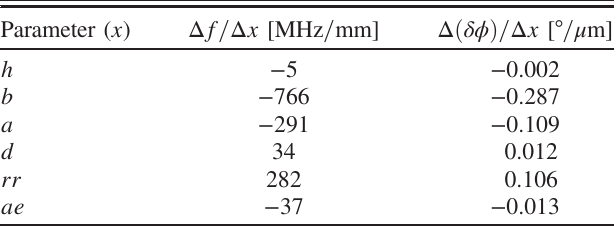
TABLE VI. Sensitivity analysis of the frequency and cell-to- cell phase advance versus geometrical error for different dimen- sions as indicated in Fig. 8 and listed in Table III. The relation Δ